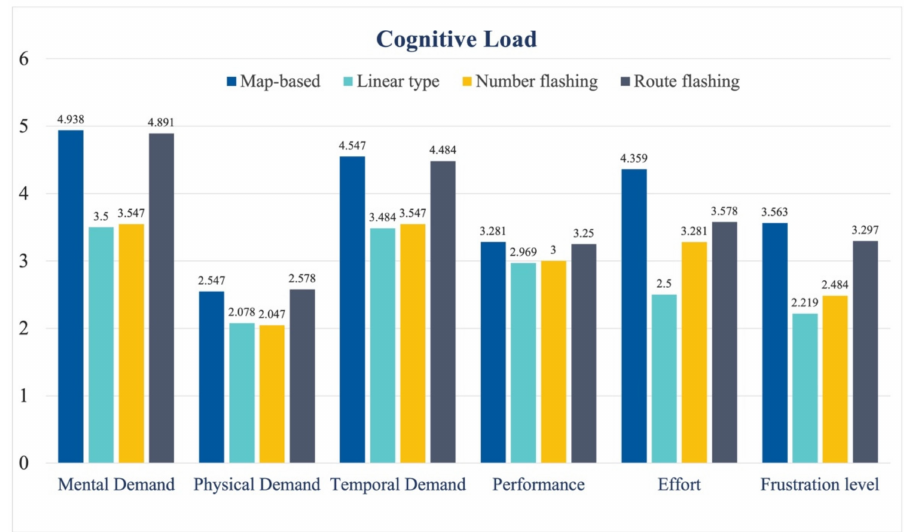
Figure 7. Results of cognitive